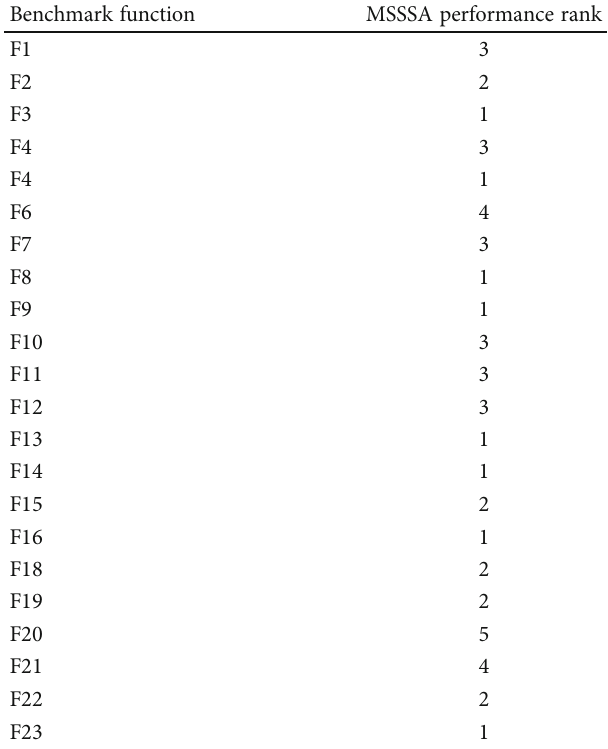
Table 3: MSSSA performance rank.